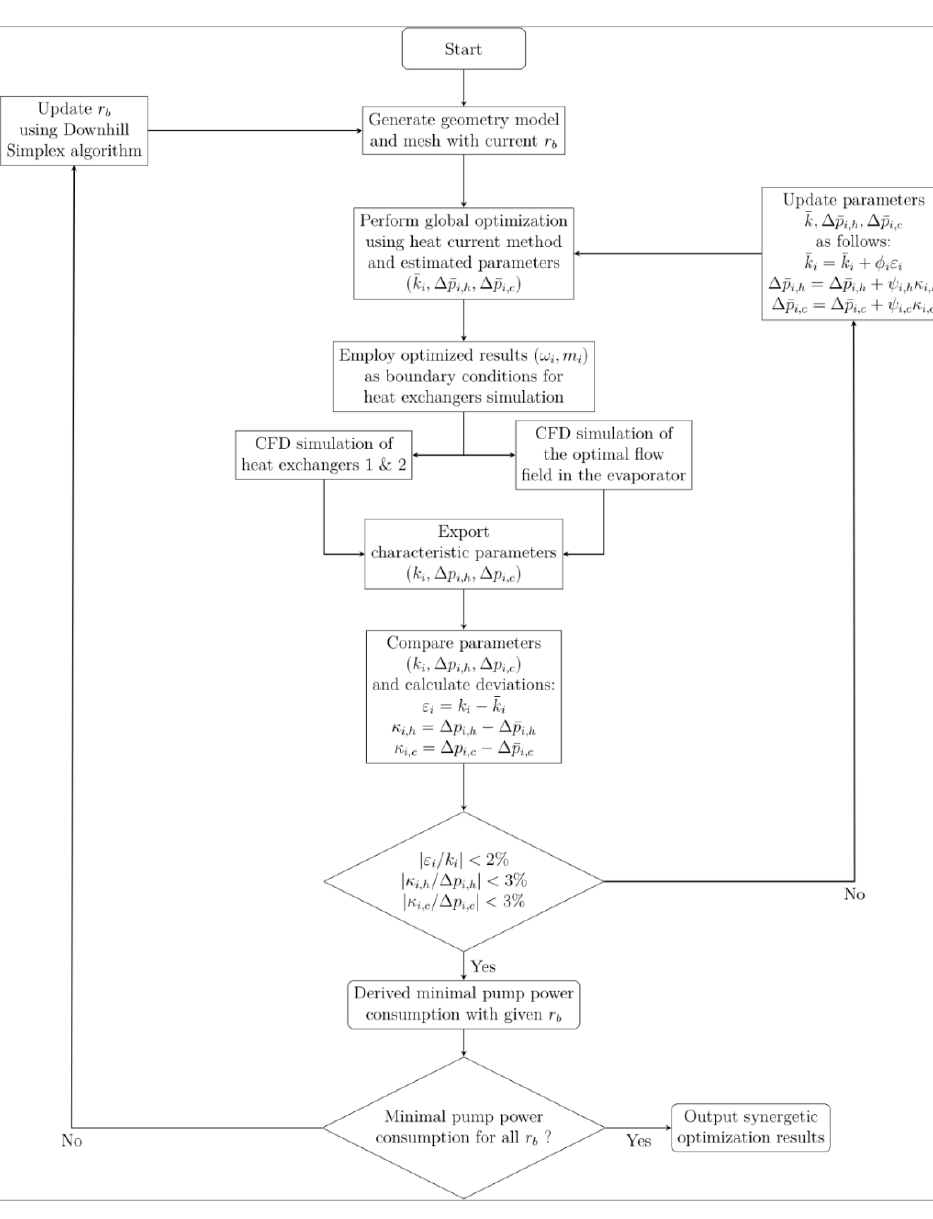
Table 1. Conditions used in the HTS optimization.